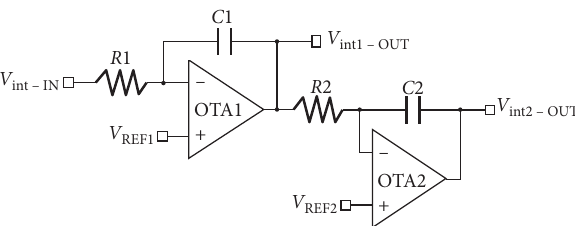
Figure 8: Output FFT with different orders at f